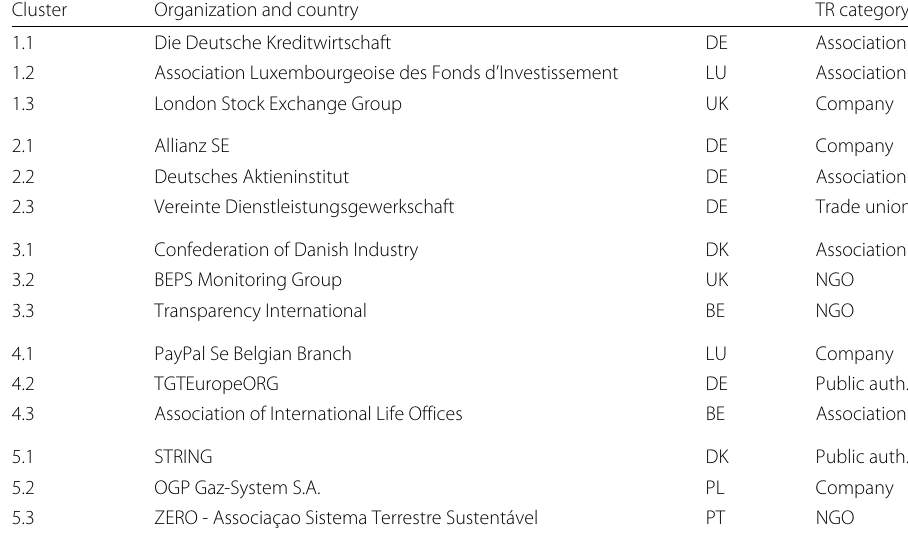
Table 5 The medoid organizations of each co-voting cluster